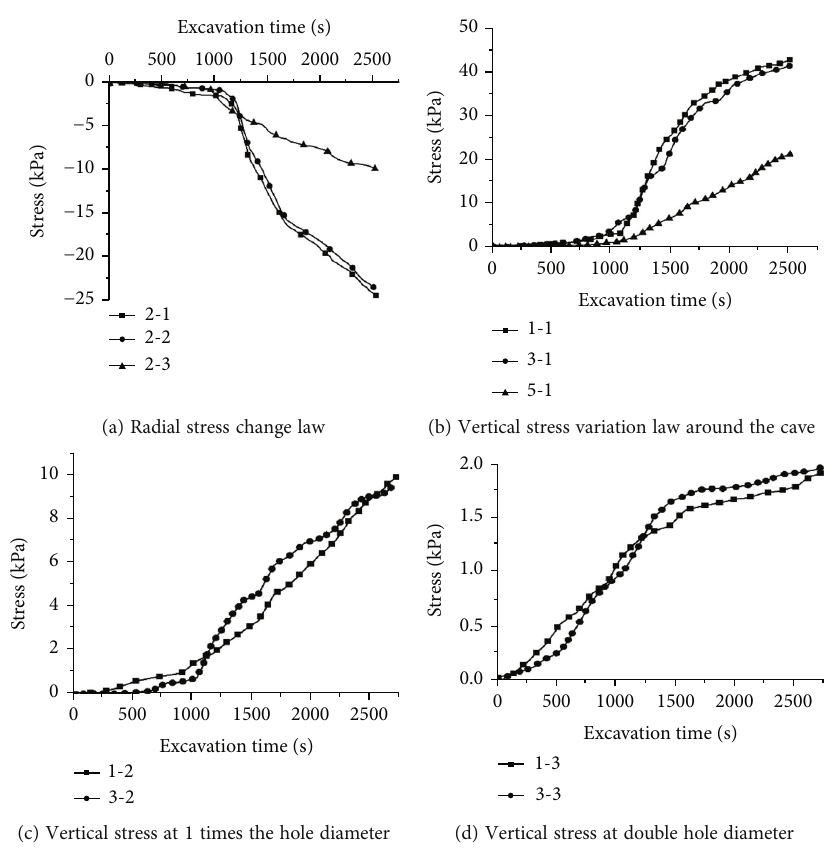
Figure 9: The law of stress change at the measuring point in the excavation